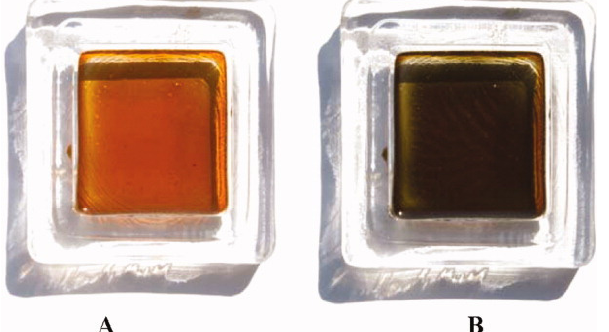
Figure 21. Photopolymerization of EPOX under sunlight ( A ) resin before sunlight exposure ( B ) resin after 5 min. of exposure to sunlight. Reprinted from Ref. [235] , Copyright 2010, Wiley.